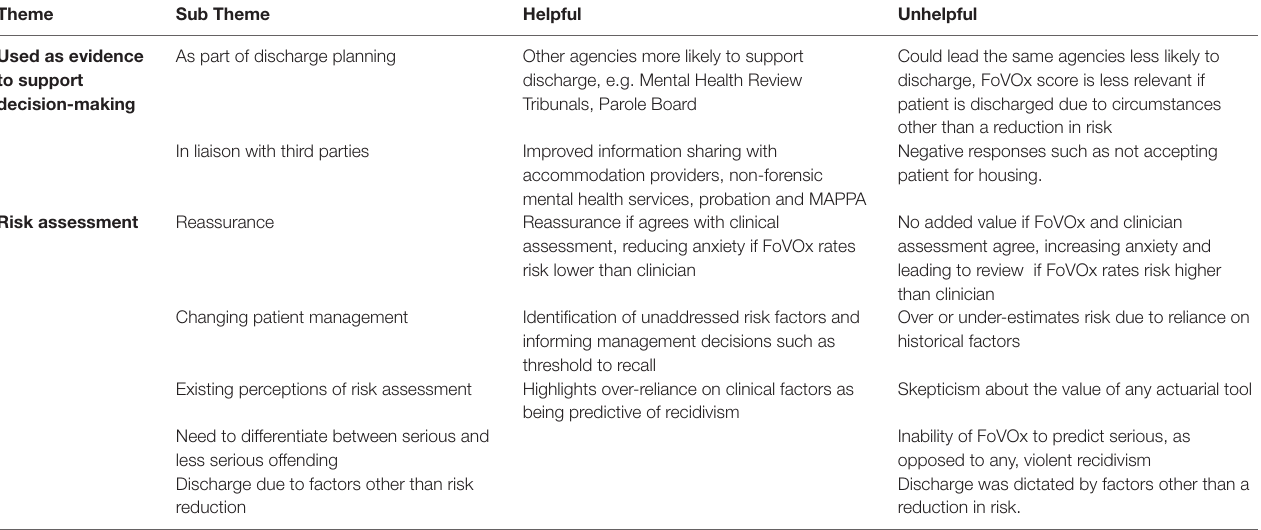
TABle 3 | Qualitative feedback on the usefulness of FoVOx